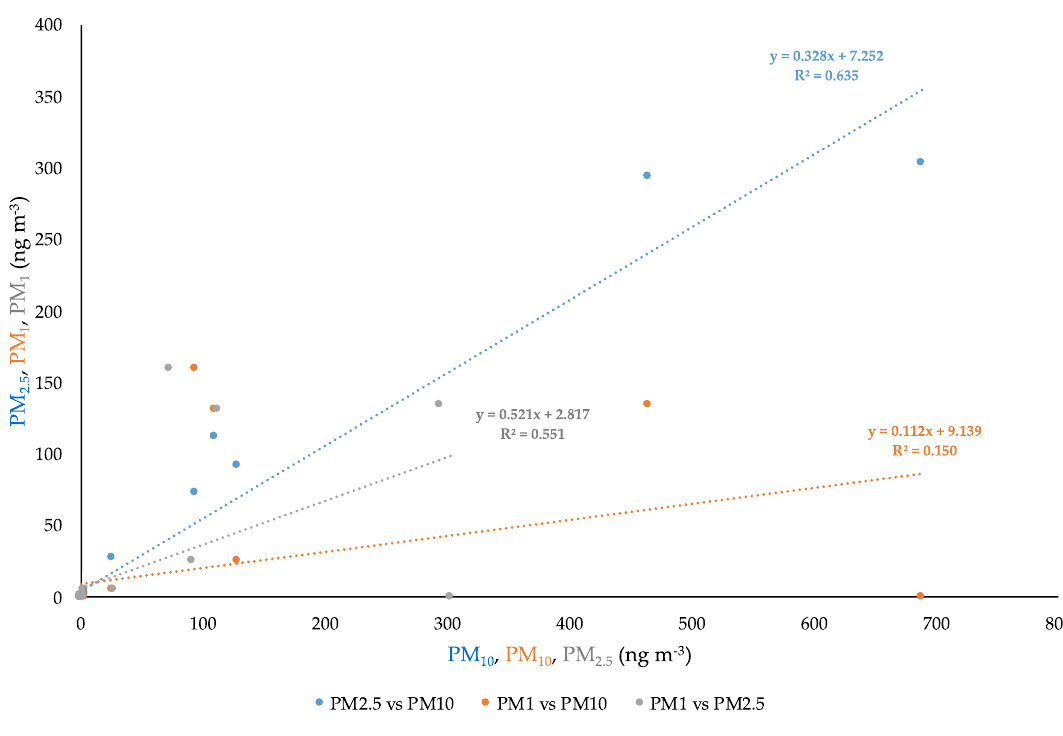
Figure 1. Relationship between the concentration elements in the PM fraction: correlation curves, linear equations, and regression coefficients (R 2 ).